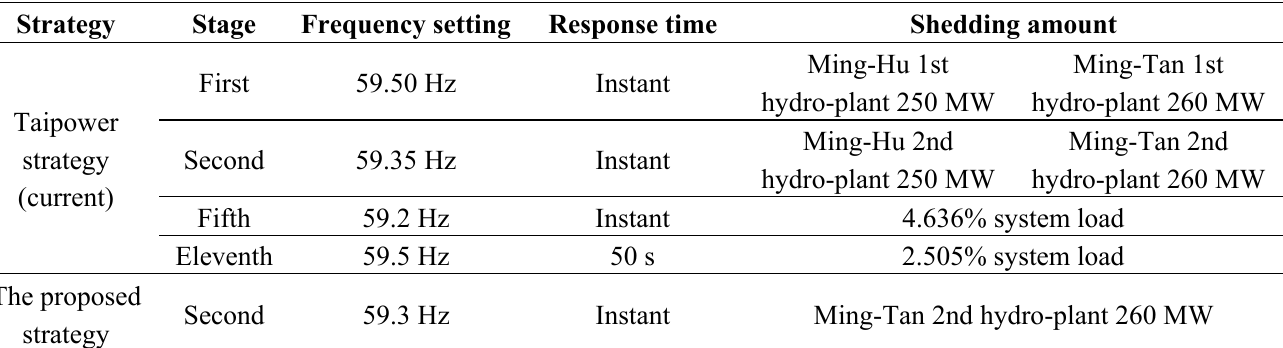
Table 1. Schemes of the Pumped-Storage Units Under-Frequency Load